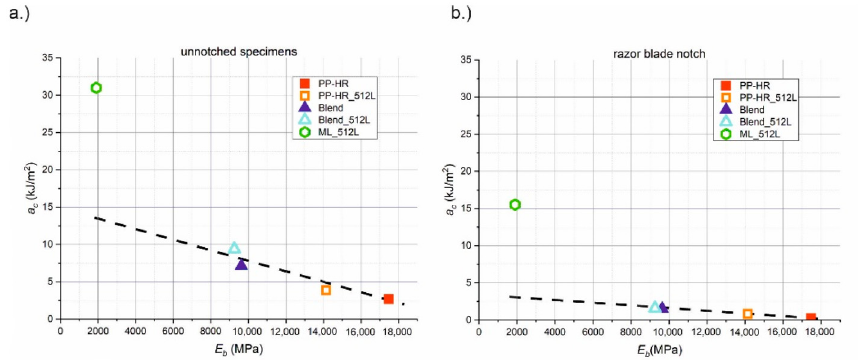
Figure 5. Comparison of stiffness and toughness showing impact strength versus the bending modulus E b for ( a ) unnotched and ( b ) razor blade notched specimens.